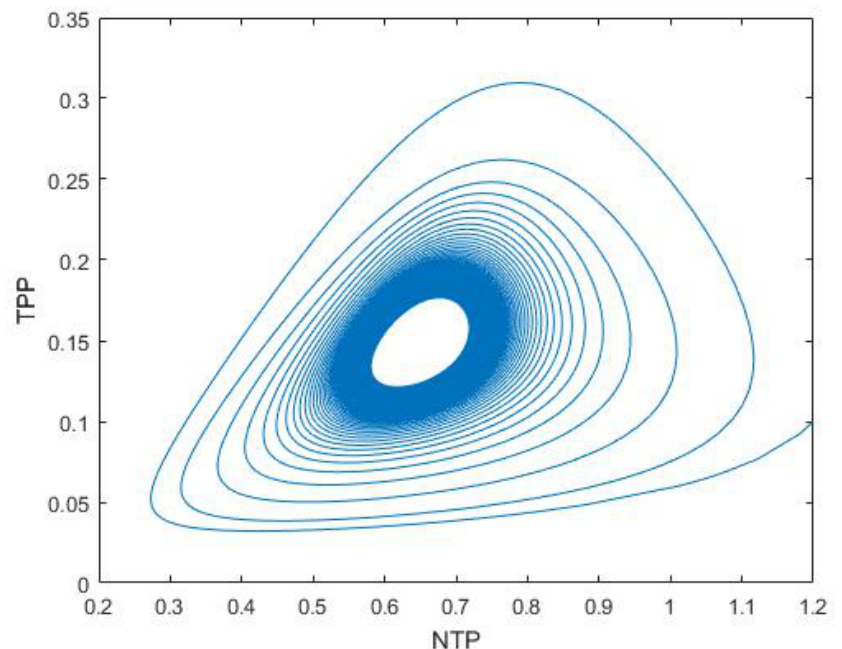
Figure 12. Equilibrium between the NTP and TPP populations loses its stability for τ < τ 0 .